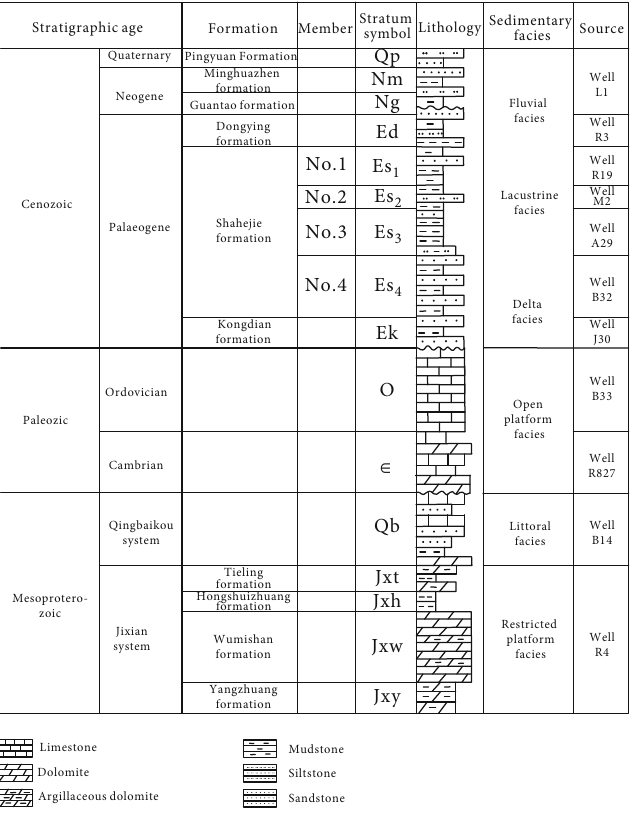
Figure 2: Stratigraphic histogram in the study